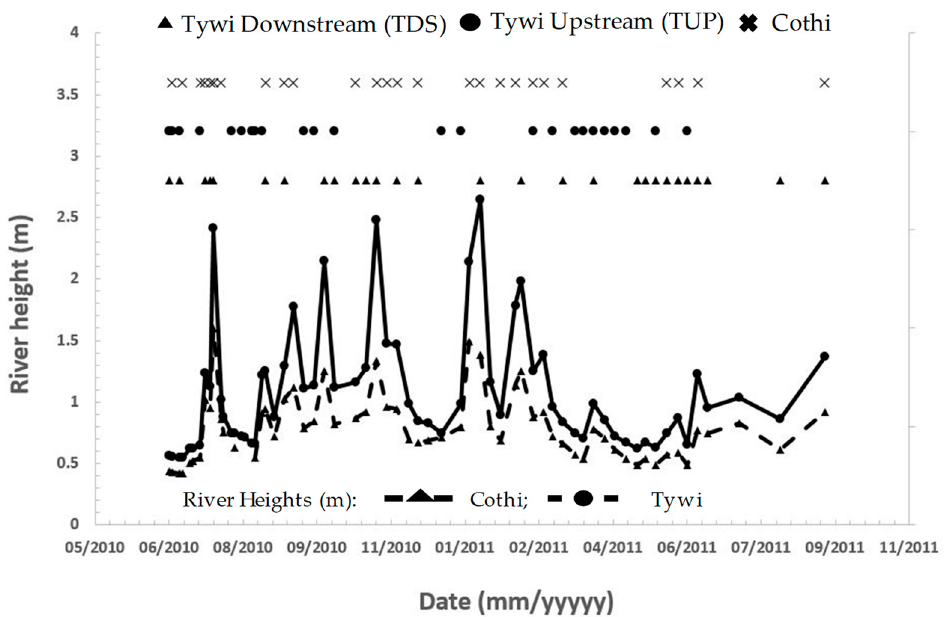
Figure 2. The presence of Map in the rivers Tywi and Cothi (Wales, UK) compared to their respective river heights (m).